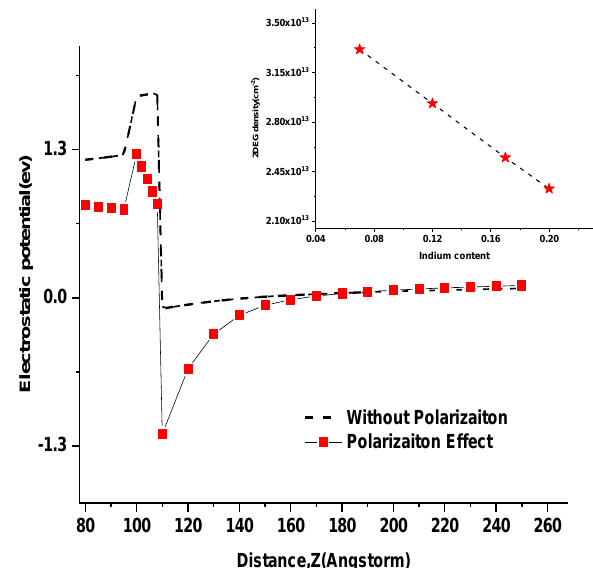
Figure 2. Sketch of the band bending with (solid, red) and without (dash, black) the polarization effect being taken into account. The calculated 2DEG density for a 10 nm InAlN/AlN/GaN heterostructure as a function of indium fraction is given in the inset.